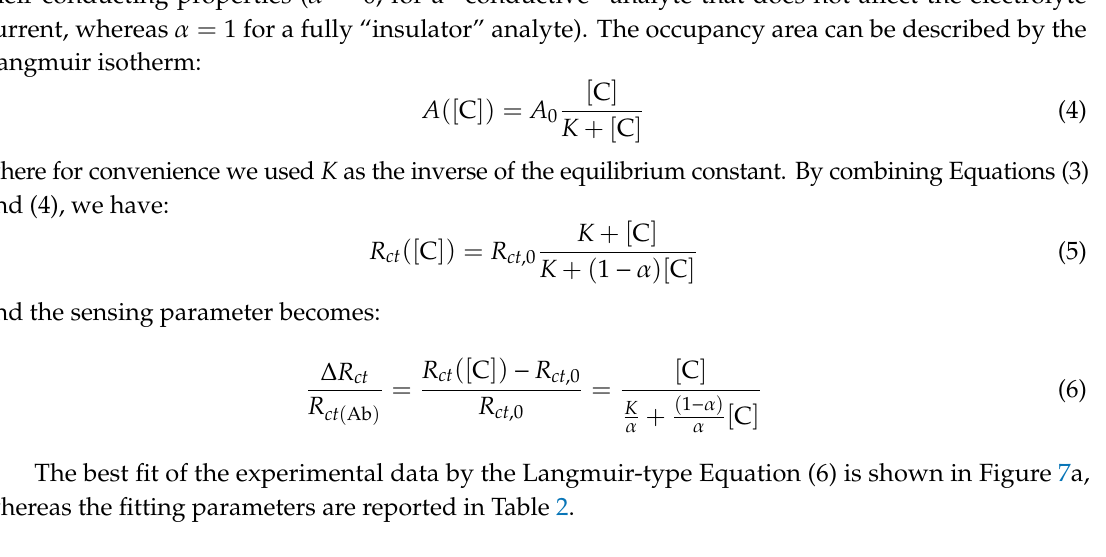
Table 2. Fitting parameters α and K obtained for both protocols DDP and